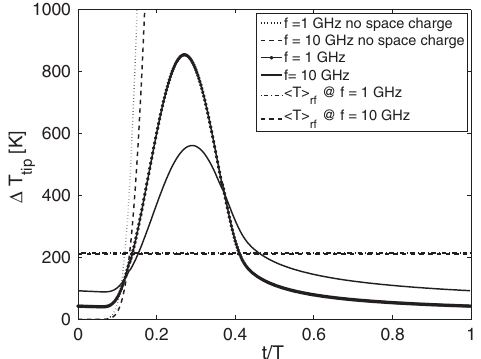
FIG. 7. Comparison of (cid:2) T , change in tip temperature during the last rf cycle of a 100 ns pulse versus normalized time, between 1 and 10 GHz cases. (cid:5) (cid:3) 47 and F o ¼ 300 MV = m . Radio-frequency (rf) mean of the change in temperature is shown with the dashed line. The dotted lines show the evolution of the tip temperature during the first cycle in the 1 and 10 GHz cases, respectively, when space charge is